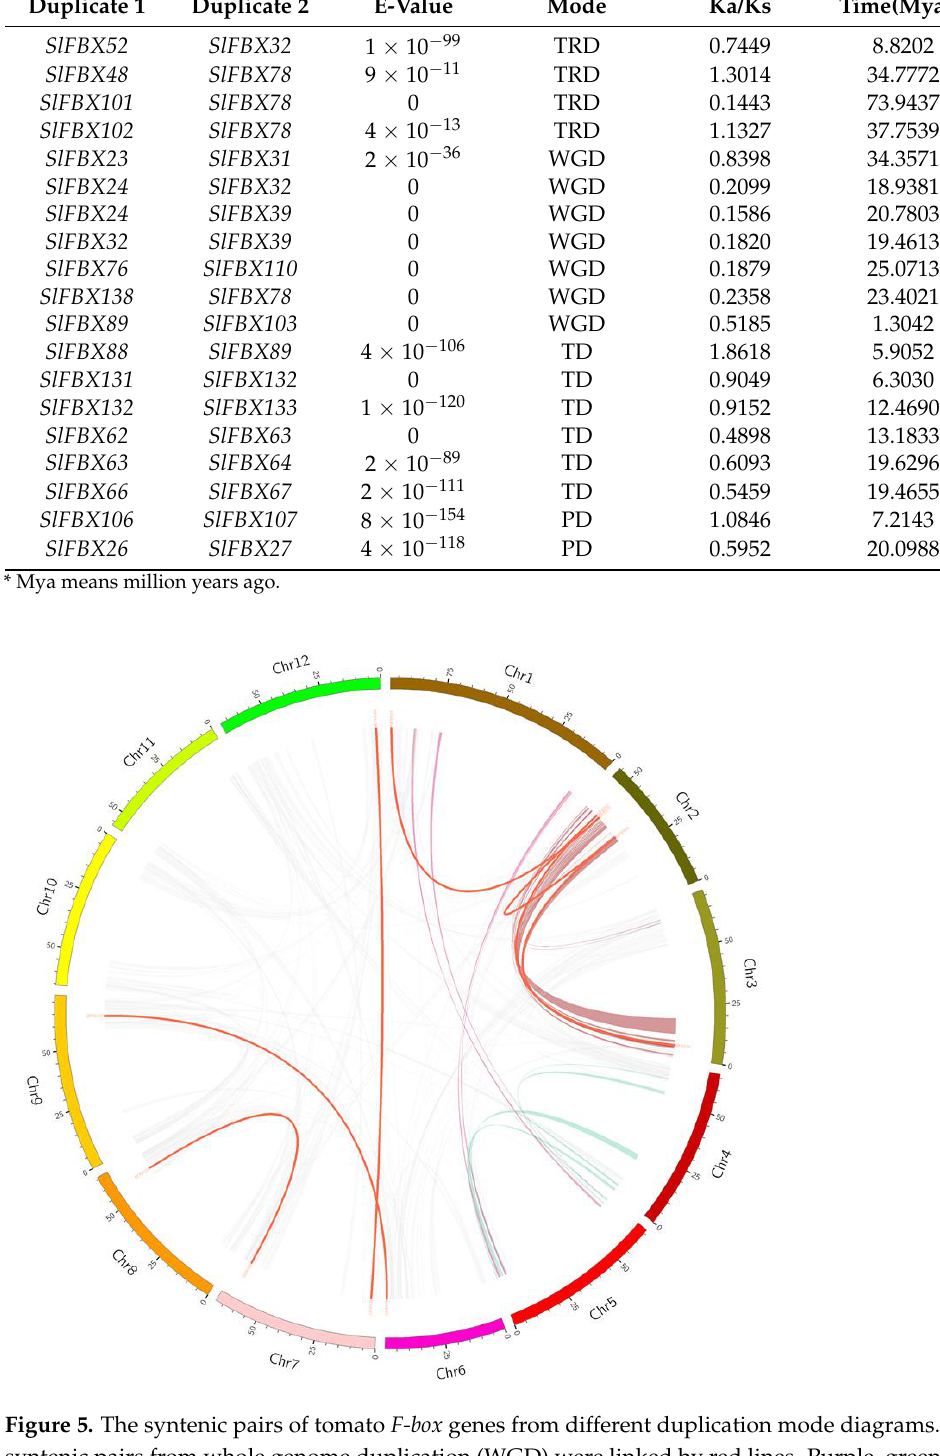
Table 1. The duplication pairs genes of SlFBX gene family in tomato.